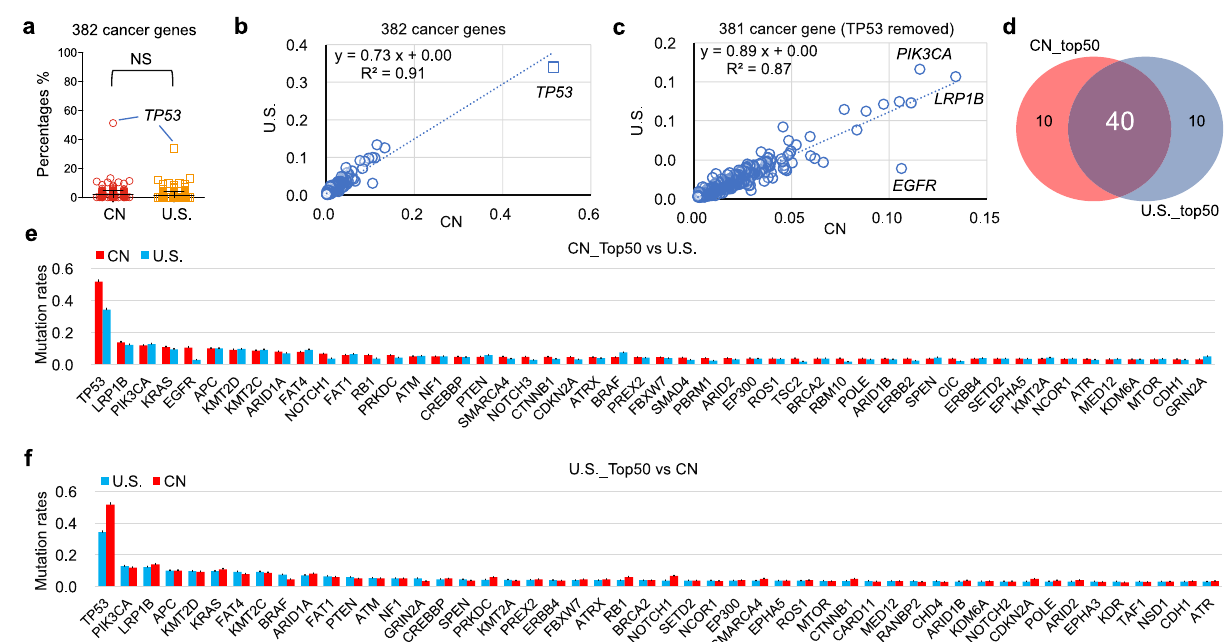
Fig. 2 | The comparison of the mutation rates of the top50 cancer genes between CN and U.S. patient population. a The comparison of the epidemiolo- gically weighted mutation rates of the 382 cancer genes derived from CN pan- cancer datasets ( n =11,948 patients) and U.S. pan-cancer datasets ( n =18,584 patients), p =0.2014 (unpaired t test with Welch ’ s correction, two-tailed, Welch- Corrected t =1.279, df =713; F test: F =1.707, DFn =381, Dfd =381, p <0.0001), CN _ Mean±SE=0.02067±0.001578 ( n =382 genes), U.S. _ Mean±SE=0.01813± 0.001208 ( n =382 genes), 95% con fi dence interval − 0.001354 to 0.006437. b The correlation analysis visualizing the epidemiologically weighted mutation rates of the 382 genes observed in CN and U.S. patient populations, the blue dashed line indicates the linear trend, Pearson r =0.9542, 95% con fi dence interval 0.9443